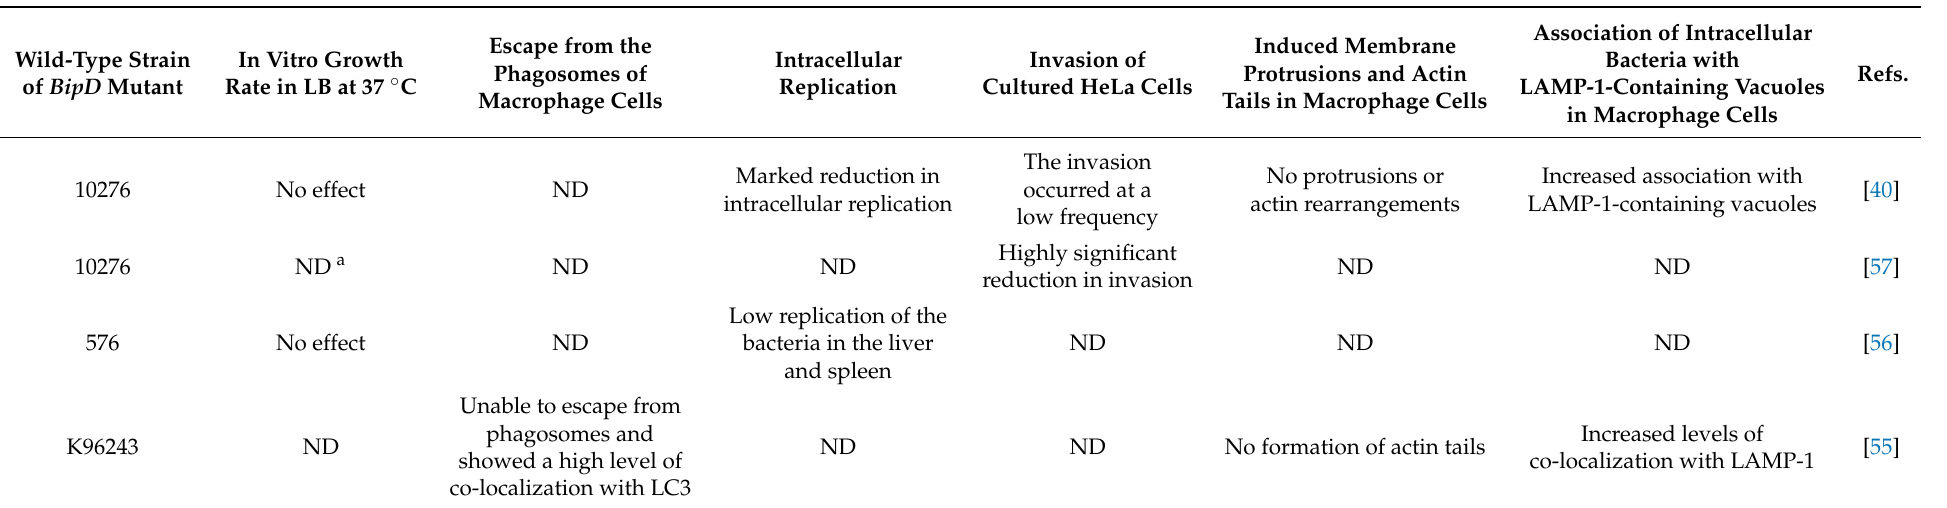
Table 2. Characterization of bipD mutants in the pathogenesis of